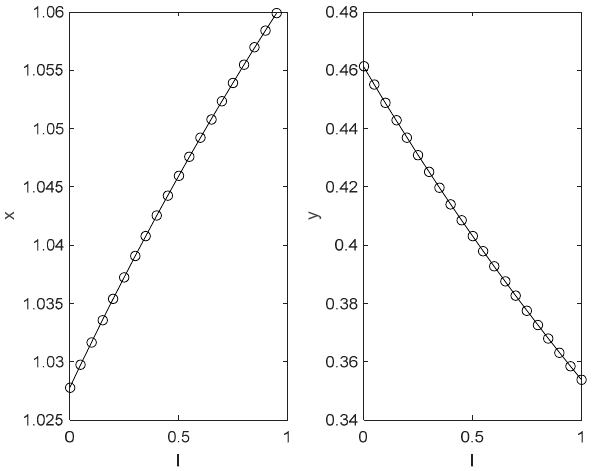
Figure 5. The impact of enterprises’ emission reduction capacity on the choice of enterprises’ green technology innovation strategy and local governments’ environmental regulation strategy.